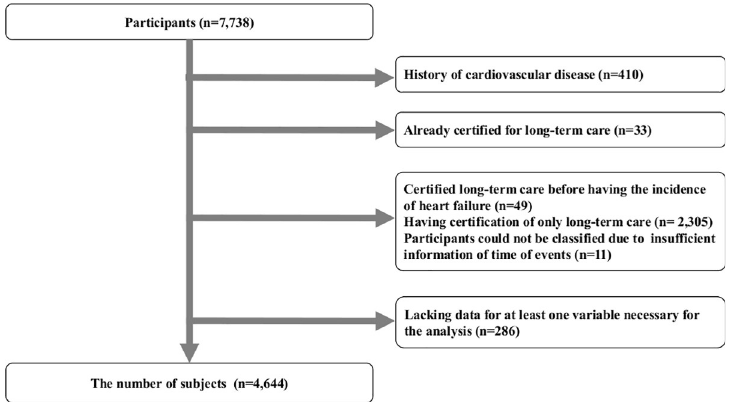
Fig 2. Flowchart of subject selection. The number of participants in the original cohort consisted of 7,738 people in the baseline survey. After all the necessary exclusions, 4,644 people remained in the present study.